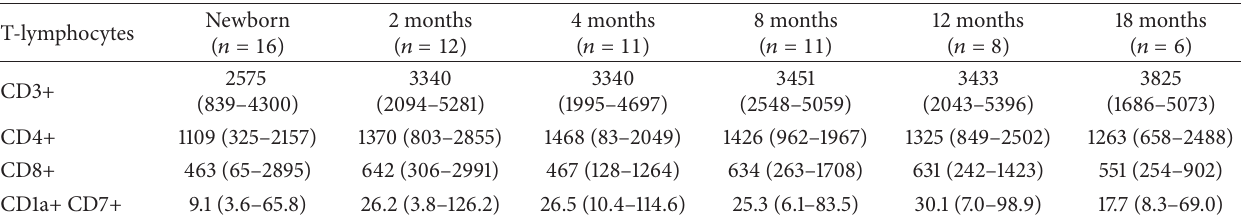
Table 5: Distribution of T-lymphocyte subsets in HIV exposed uninfected infants given as median and range (min–max) and the number of infants ( 𝑛 ). Cell count is given in cell/ 𝜇